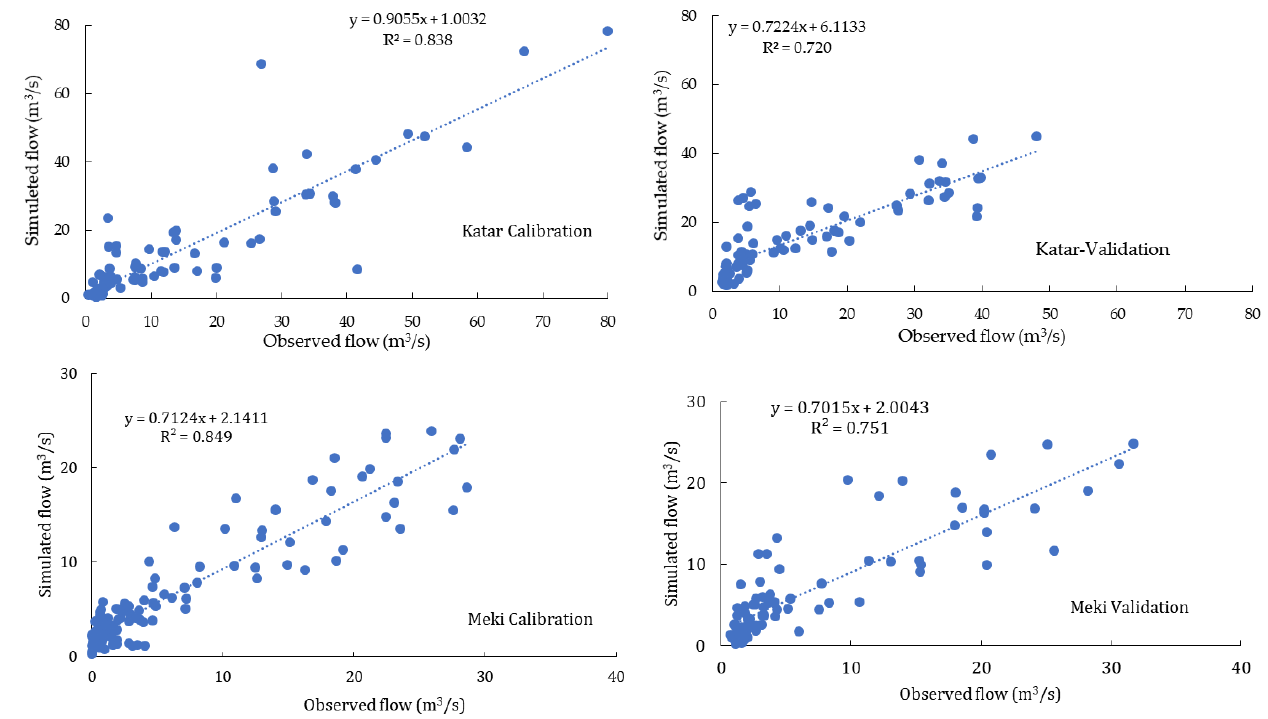
Figure 6. Monthly correlation of observed and simulated flow during calibration and validation of Katar and Meki subbasins.